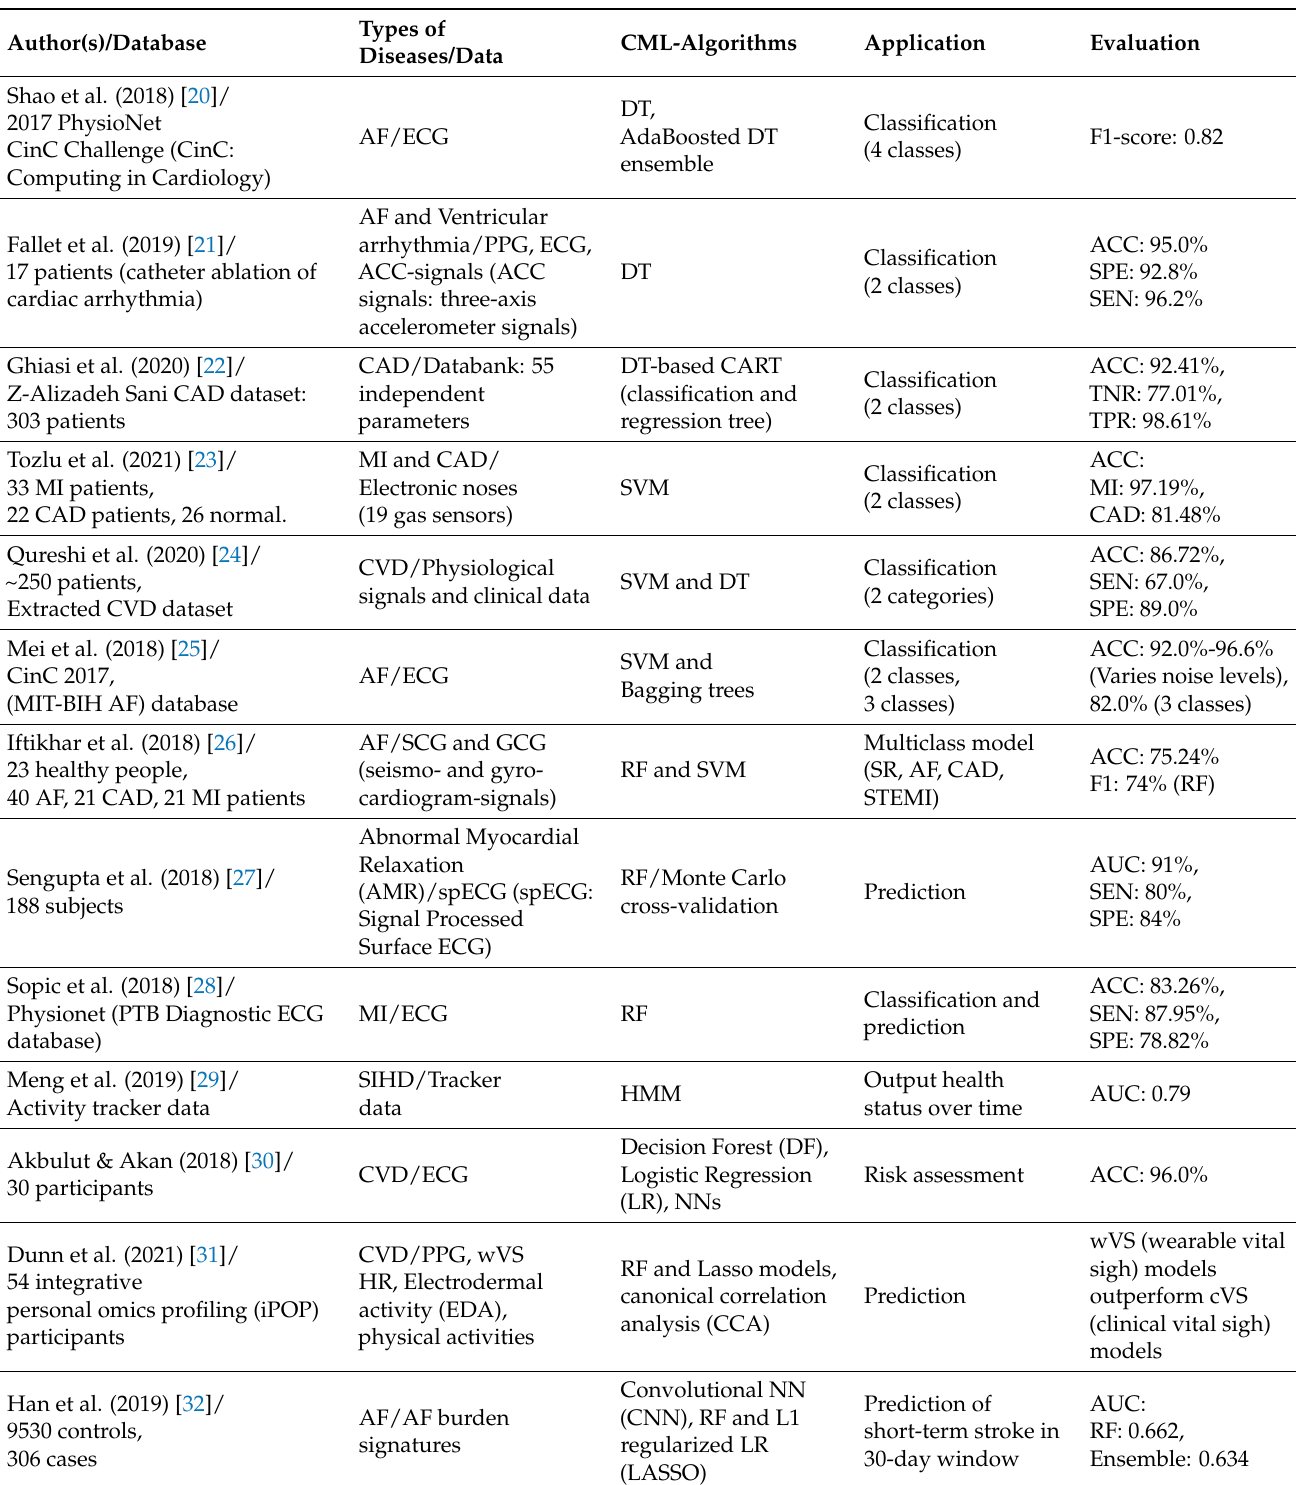
Table 1. Performance comparison of classical machine learning algorithms for wearable de- vice